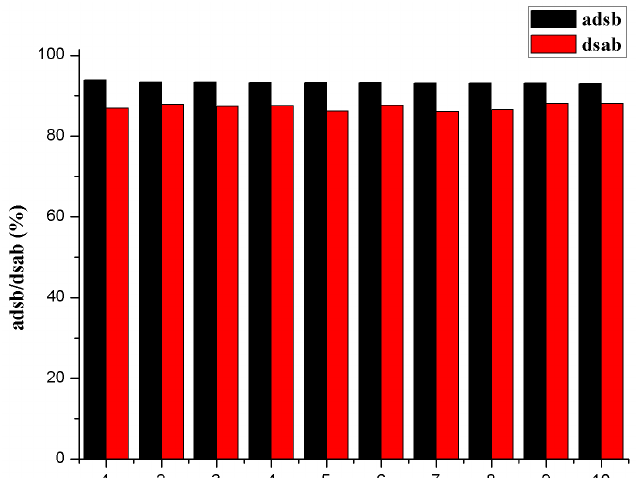
Figure 12. The amount of Th 4+ adsorbed as a function of the adsorption-desorption cycle. Adsorption (adsb) and desorption (dsab) cycles: adsorption-sample volume = 5.0 mL, Th(IV) concentration = 6.5334 × 10 − 4 mol/L, adsorption dose ( β -CD(AN- co -AA)) = 0.30 g/L, initial pH = 2.95 ± 0.05, equilibration time = 4 h; desorption-sample volume = 5.0 mL of 0.09 M HNO 3 .